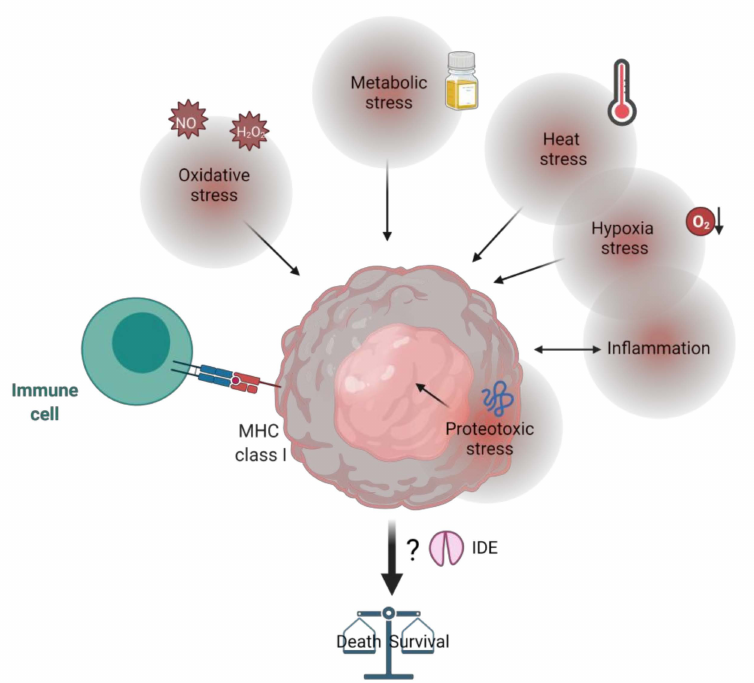
Figure 3. Impact of the environment on cancer cells that could involve IDE modulation as a response. Cancer cells are submitted to various stresses such as oxidative, metabolic, heat, hypoxia, proteotoxic stresses, inflammation and immune recognition that induce a response that can allow cell survival or death. It is known that IDE can modulate or be modulated by these different stresses. Created with BioRender.com (31 March